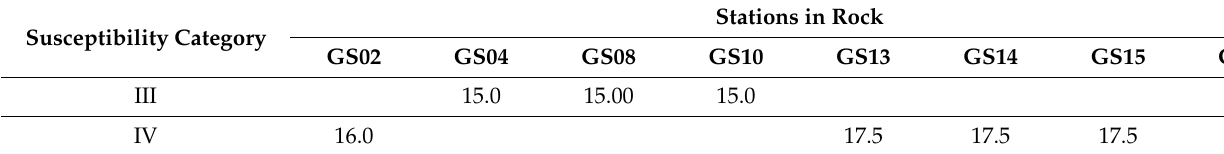
Table 15. Assessment of detachment susceptibility in rock mass.